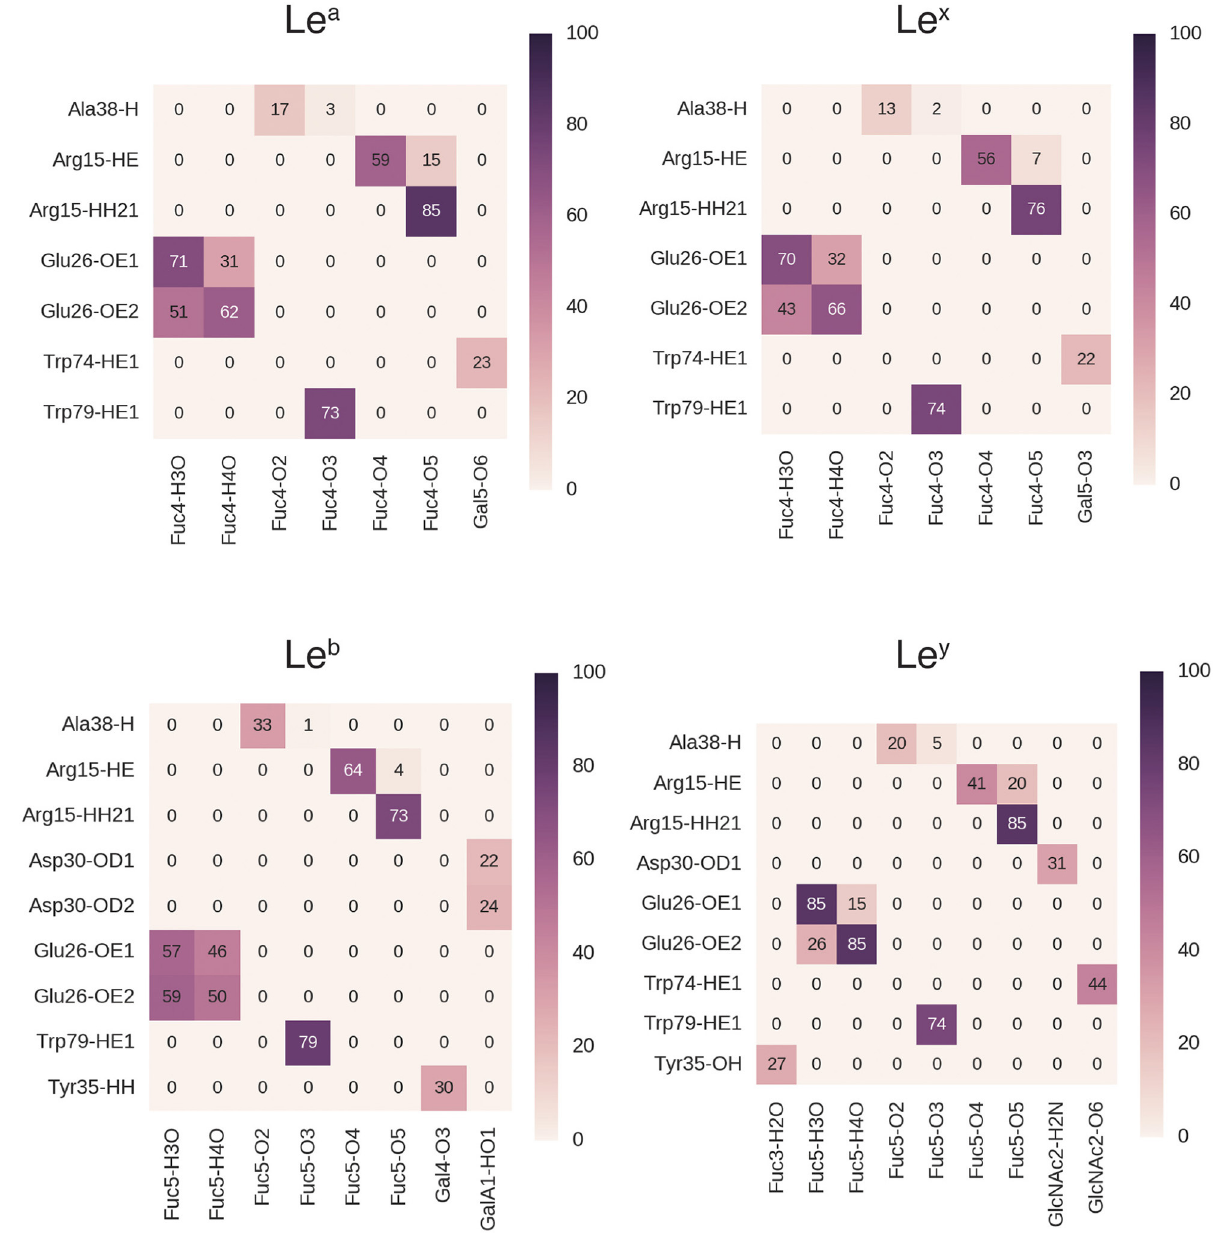
FIGURE 6 | Hydrogen bond interactions in BambL-saccharide complexes during MD simulations shown for Lewis group saccharides. Atoms are named to the conventions of the PDB exchange dictionary. Grid cells are colored and labeled by average occupancy from three replicate simulations. Occupancy values were calculated by dividing the number of frames in which the hydrogen bond exists by the total number of simulation